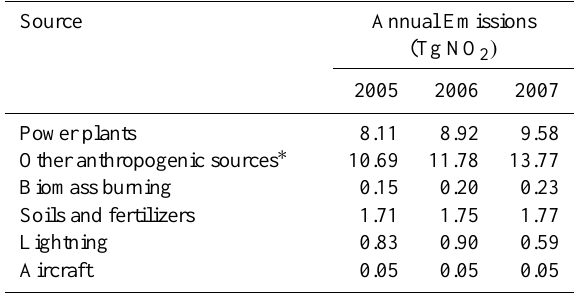
Table 1. A priori annual GEOS-Chem NO x emissions in 2005– 2007 in mainland